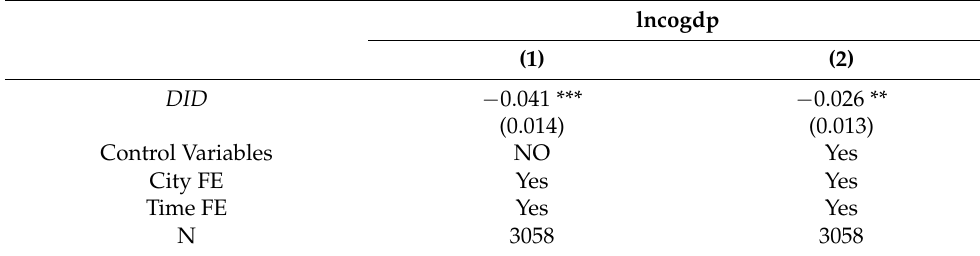
Table 8. Replace the dependent variable.